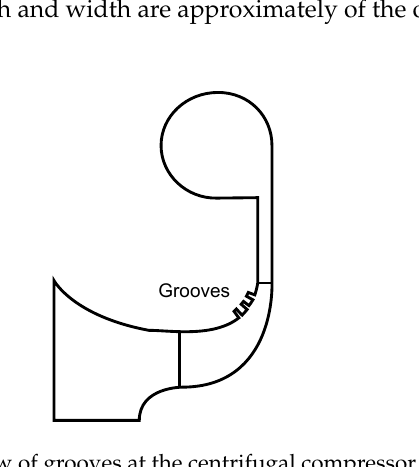
Figure 13. Schematic view of grooves at the centrifugal compressor shroud